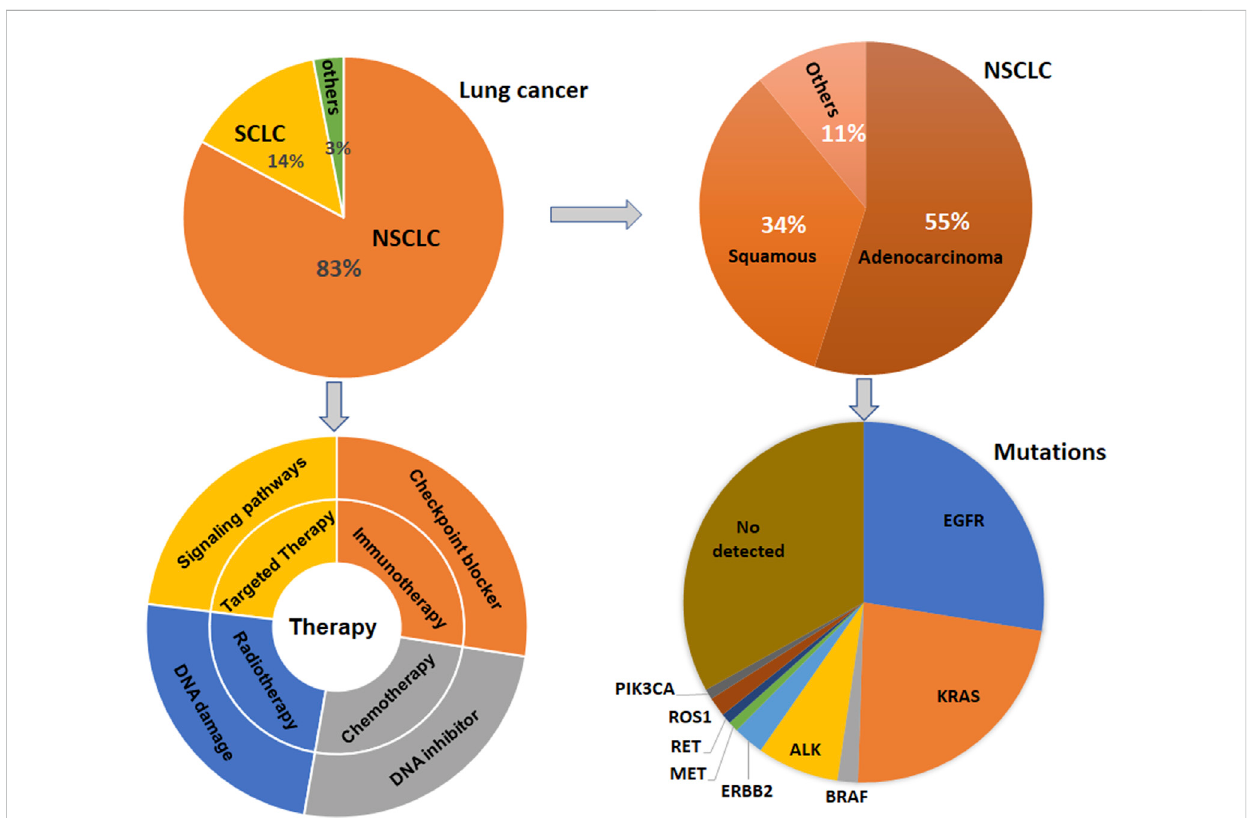
Gene Mutations and therapies are illustrated in lung cancer. Lung cancer has three-type categories, including SCLC, NSCLC, and unspeci fi ed histology.NSCLCpatientshavemultiplegenemutations.Targetedtherapy,immunotherapy,antiangiogenictherapyandcombinationtherapyhavebeen used in the clinic for lung cancer